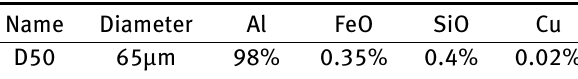
Table 1: The chemical composition and size of the aluminium pow- der.